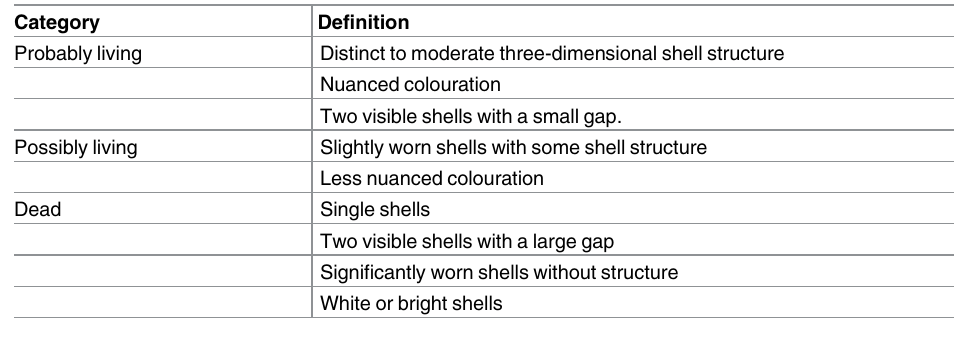
Table 1. Criteria description.